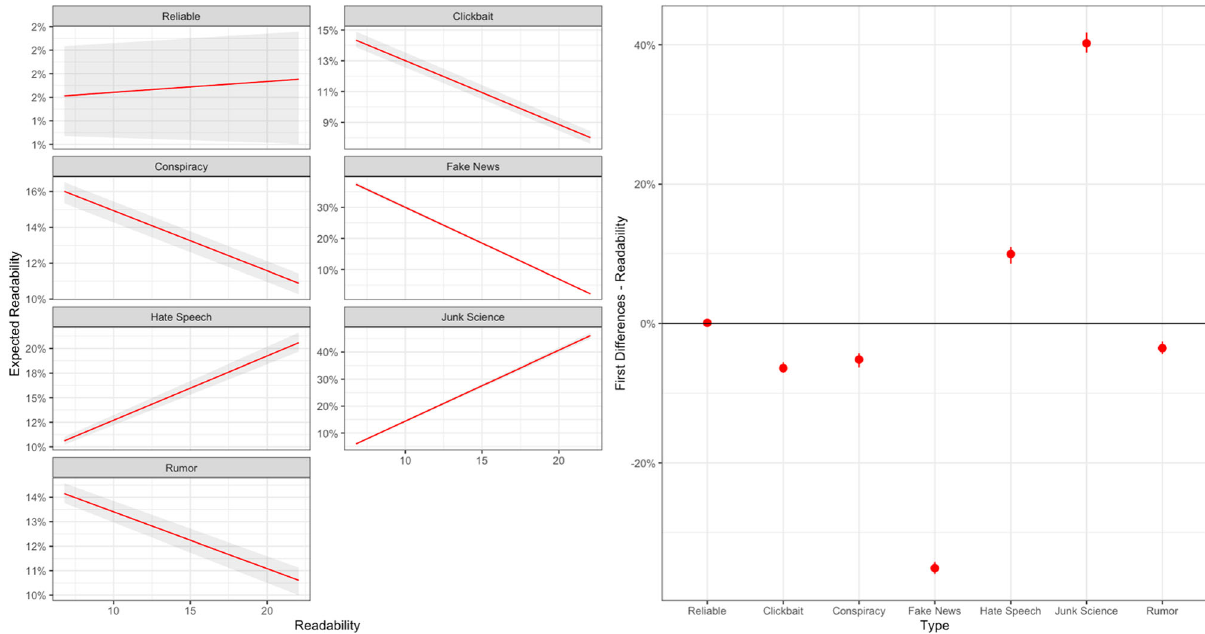
Fig. 5 First differences of the multinominal logit model −